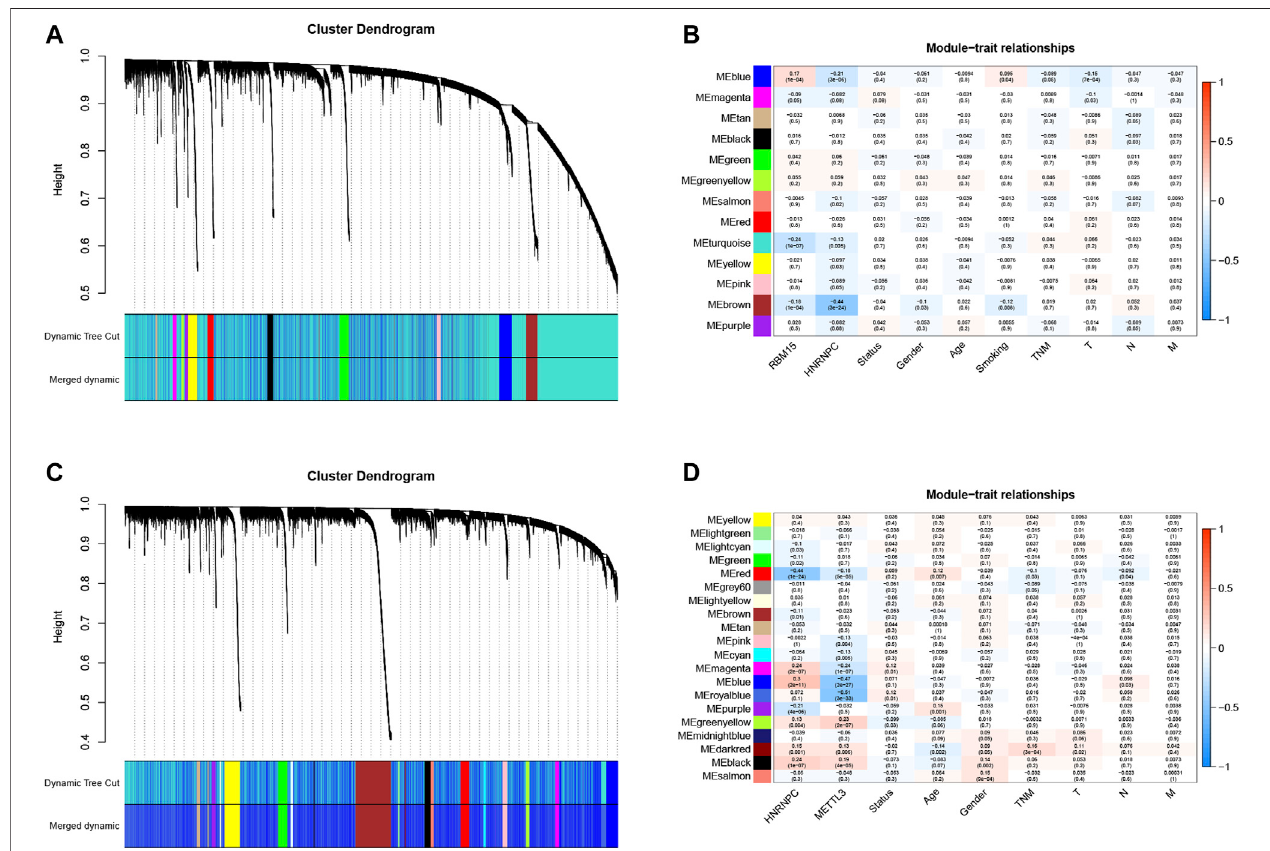
FIGURE3| Identi fi cation oftheASevents thatareassociatedwithclinicaltraits and theexpressionofm6Aregulators. (A) HierarchicalclustertreeoftheASevents in TCGA-LUAD samples. The tree indicates a unique TCGA-LUAD name and experiment identi fi er. (B) Association of the AS events with gender, age, LUAD lymphatic in fi ltration, tumor status, and pathological stages. The number represents the Pearson correlation values between the module and the features. The number in parenthesisisthe p -value,whilethenumbersinthecolorcolumnrepresenttheintensityofthecorrelationinthetable(red (cid:1) 1,blue (cid:1)− 1). (C) Hierarchicalclustering tree of the AS events in TCGA-LUSC samples. The tree indicates a unique name and experiment identi fi er marked TCGA-LUSC. (D) Association of the AS events with gender,age,LUSClymphaticvesselinvasion,tumorstatus,andpathologicalstages.ThenumberrepresentsthePearsoncorrelationvaluesbetweenthemoduleandthe featuresThe number in parenthesis isthe p -value,whilethenumbers inthe colorcolumn representthe intensity ofthecorrelationin thetable(red (cid:1) 1,blue (cid:1) 1). T, tumor scope;N,degreeofdiffusiontolymphnodes;M,thereisatransfer;m6A,N6-methyladenosine,LUAD,lungadenocarcinoma;LUSC,lungsquamouscellcarcinoma;AS, alternative